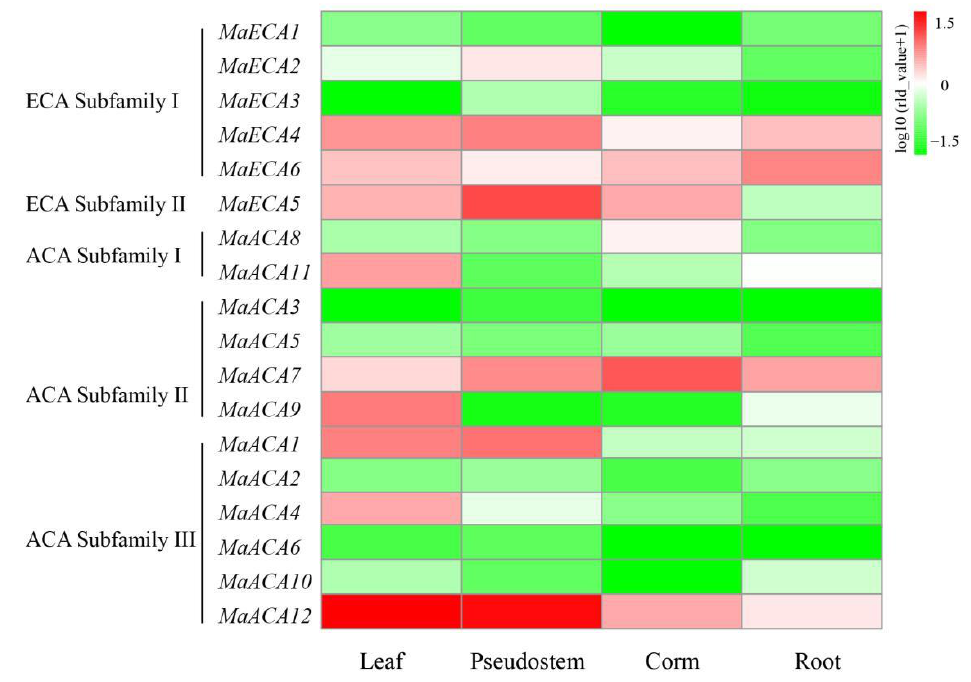
Figure 5. Heatmap for the expression of Ca 2+ - ATPase gene family members in different tissues. Red and green colors represent high and low expression levels,